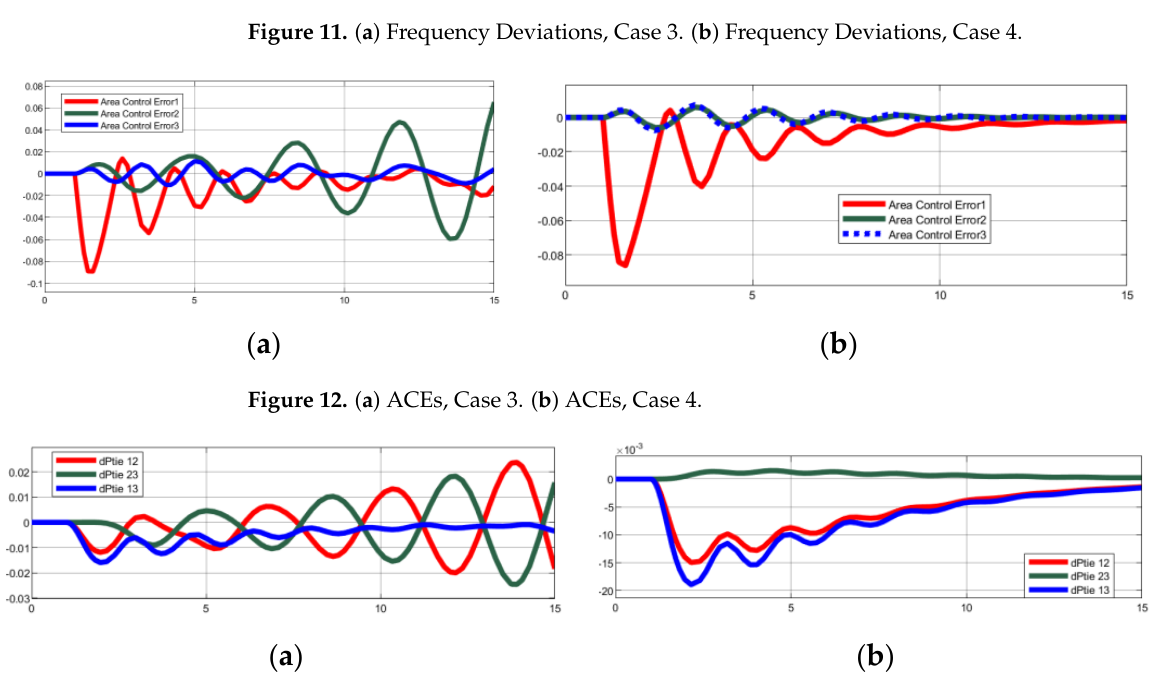
Figure 11. ( a ) Frequency Deviations, Case 3. ( b ) Frequency Deviations, Case 4.